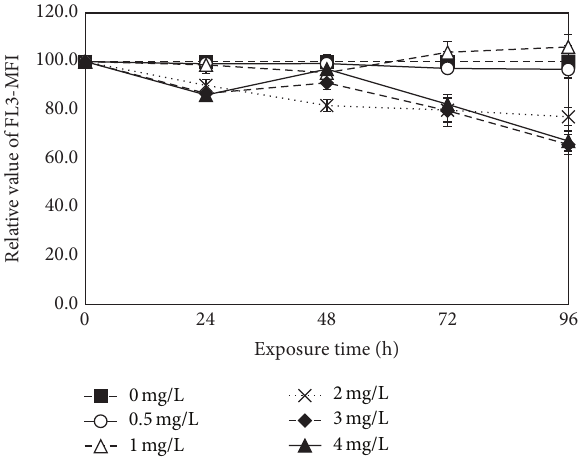
Figure 6: The effects of ethyl cinnamate on the fluorescence of chlorophyll